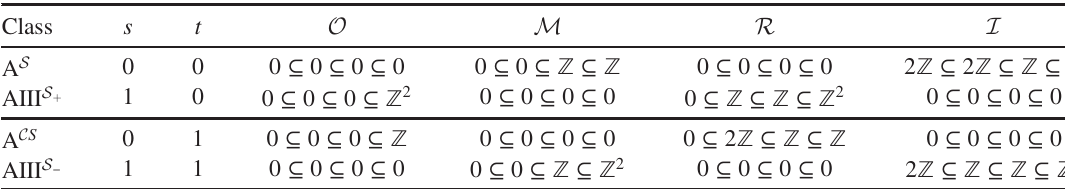
TABLE V. Bulk classification sequence (1) for three-dimensional topological crystalline phases with an order-two unitary crystalline (anti)symmetry for the complex tenfold-way classes. The symbols O , M , R , and I refer to local on-site ( d ¼ 0 ), mirror ( d ¼ 1 ), twofold rotation ( d ¼ 2 ), and inversion symmetry ( d k k k